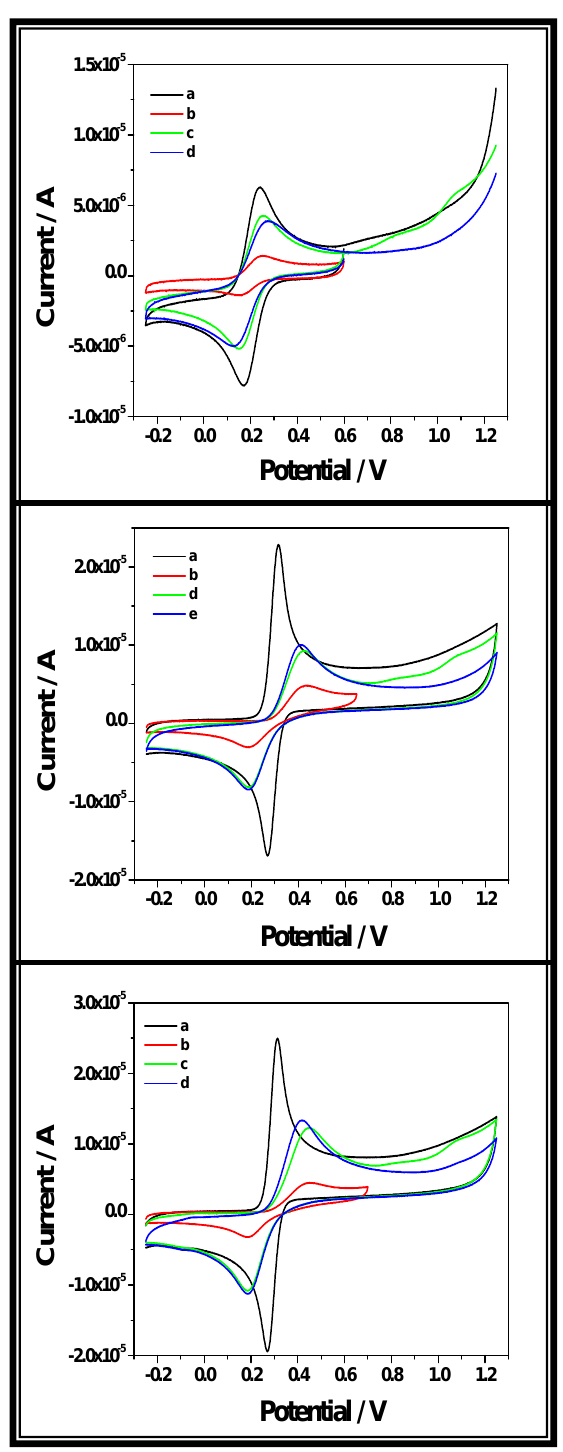
Figure 3. Cyclic voltammograms for 5.0 x 10 -4 M potassium ferricyanide (A), catechol (B) and dopamine (C) at bare GCE (black) and at dsDNA-modified-GCE obtained by casting the electrode with 5.0 µL of a 4900 ppm dsDNA solution until dryness (one cycle, without oxidizing the DNA (red); another cycle, during the DNA oxidation (green) and a last cycle, after DNA oxidation (blue)). Other conditions as in Figure 2. The state of the glassy carbon surface is another important variable for the adsorption of